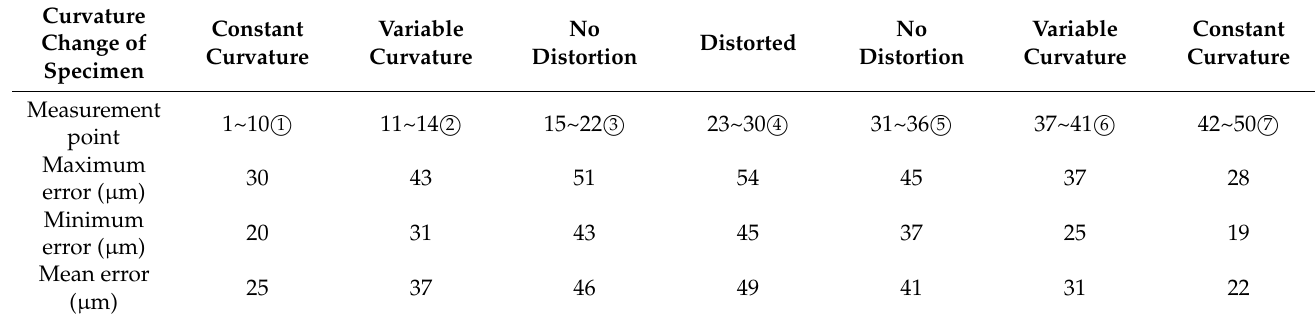
Table 2. Comprehensive error data distribution of specimens with 0 ◦ inclined plane angle.